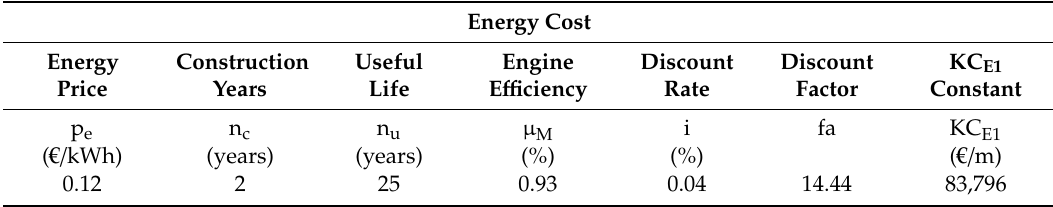
Table 4. Energy cost constant factors and calculation of the invariable part of C E1 .